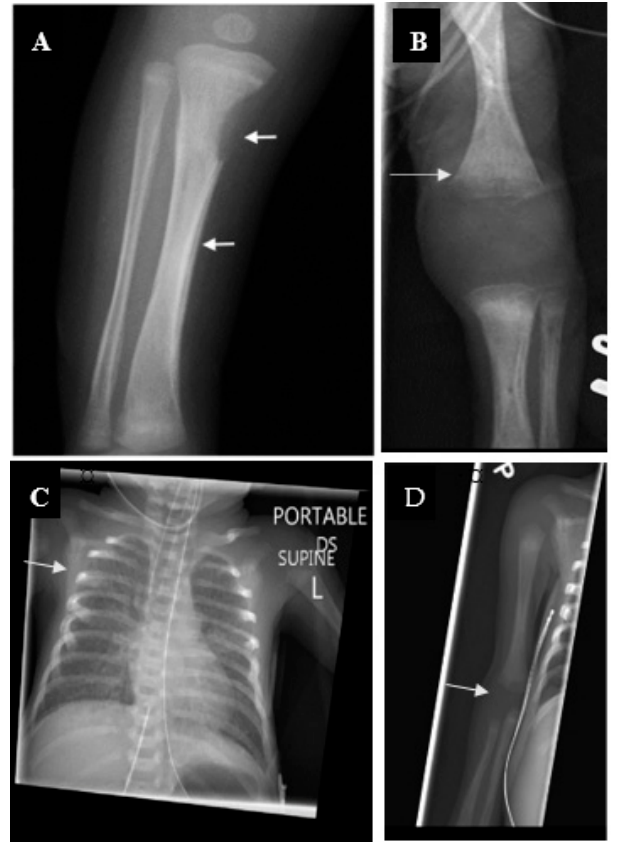
Figure 3. Neonate born to mother without prenatal care highlights importance of testing of pregnant